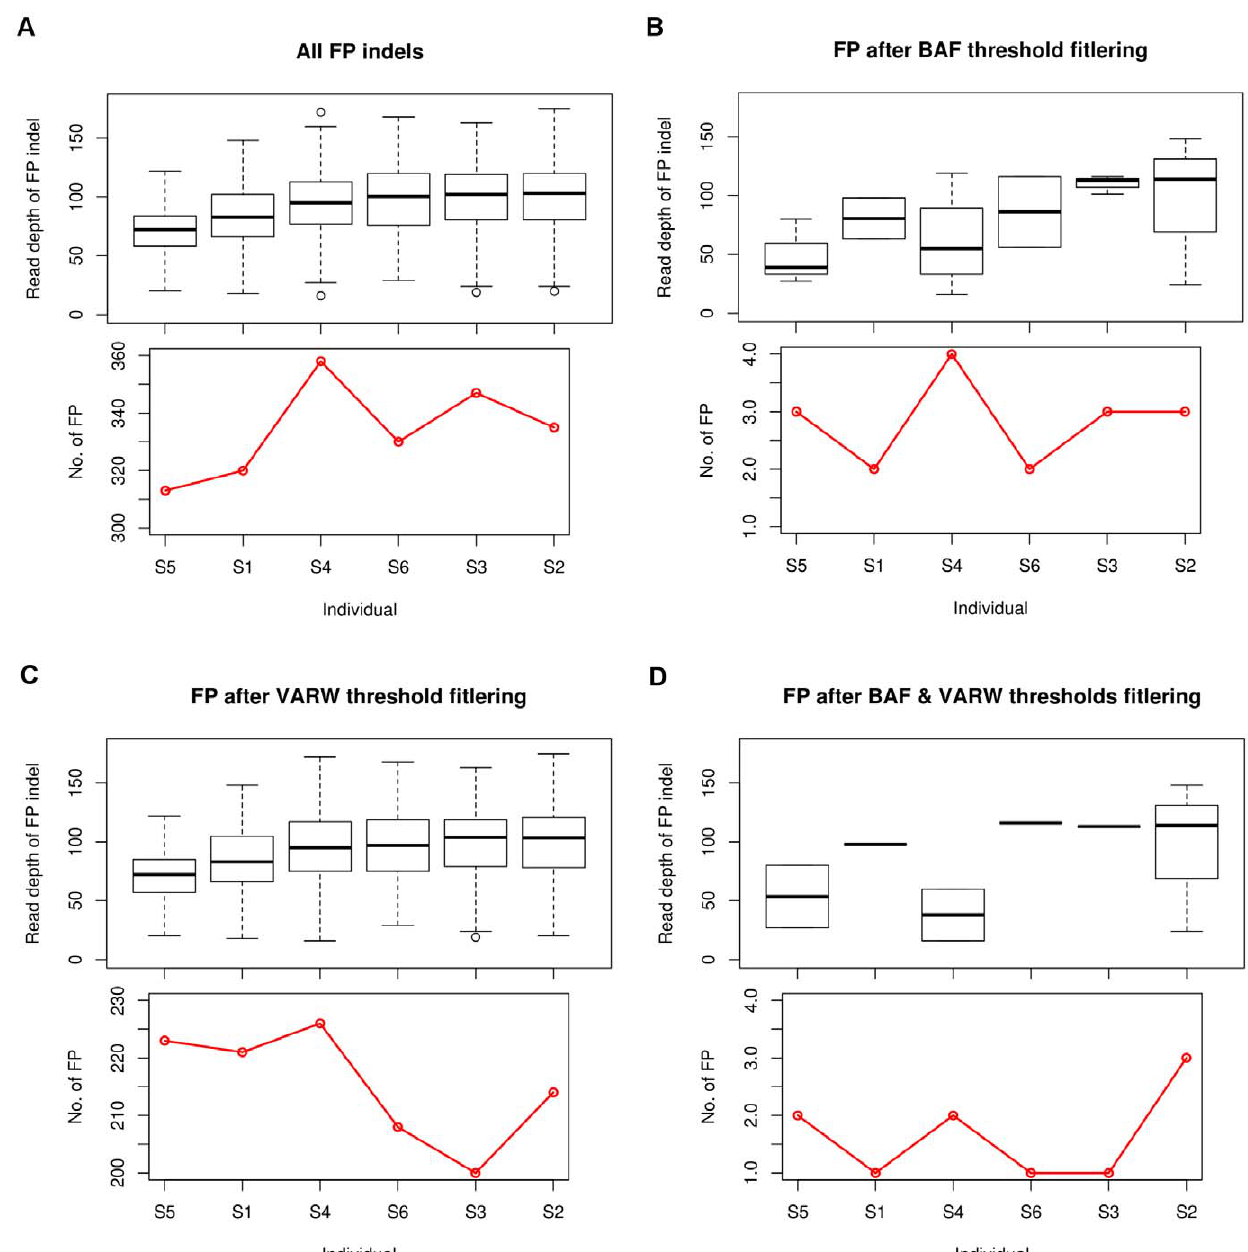
Figure 4. Number of false positive indels from BRCA1 and BRCA2 sequencing of six samples with varying read depth. (A–D) (Top) Read depth distribution of false positive (FP) indels in each sample; (Bottom) number of false positive indels in each sample. (A) Number of FP indels before BAF and VARW filtering. (B) Number of FP indels after BAF filtering. (C) Number of FP indels after VARW filtering. (D) Number of FP indels after BAF and VARW